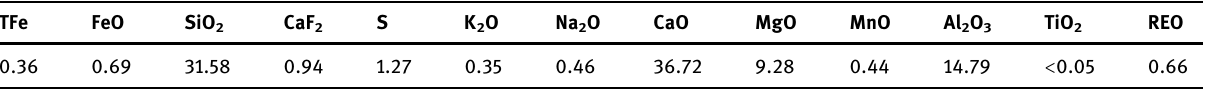
Table 1: Main chemical composition of Baogang blast furnace slag